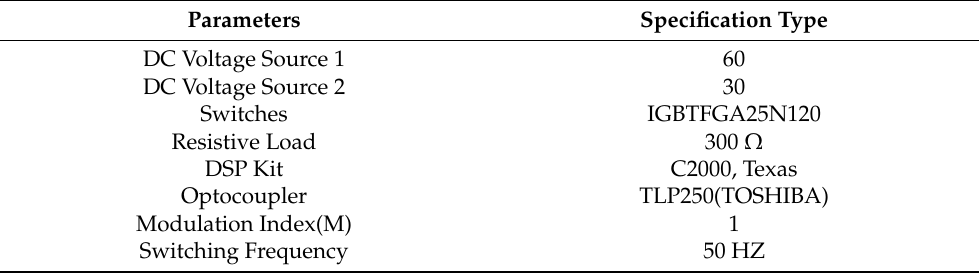
Table 5. Parameters for experimental